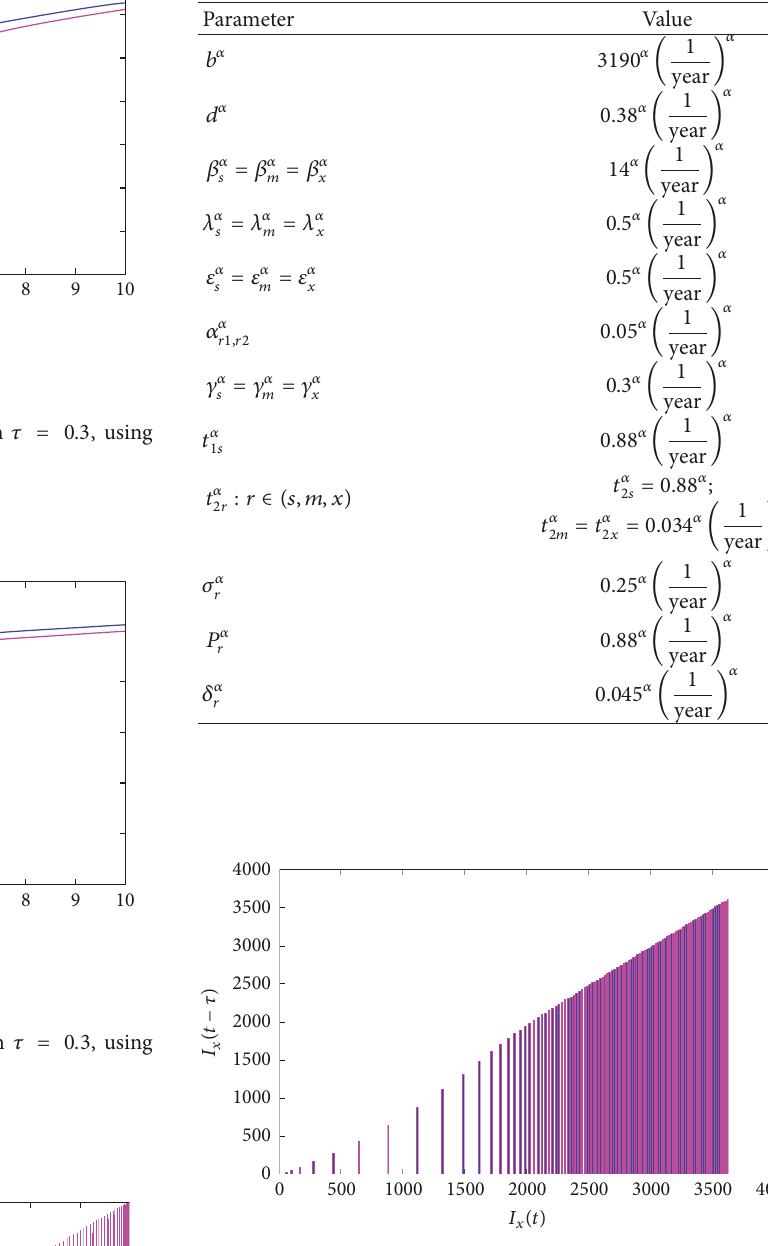
Figure 4: The relationship between 𝐼 𝑥 (𝑡) , 𝐼 𝑥 (𝑡−𝜏) with 𝜏 = 0.1 , 𝛼 = 1 using